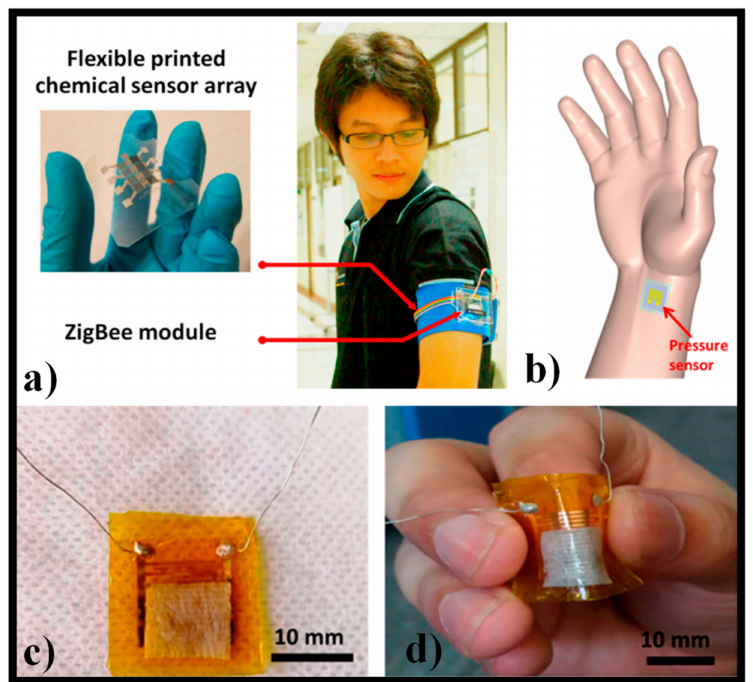
Figure 11. (a) Model of a wearable e-nose established on the adaptable inkjet-printed chemical sensor array incorporated in ZigBee wireless network. Reprinted from ref. [183]; ( b ) pressure sensor was attached to a human wrist for heart pulse detection. Reprinted from ref. [184]; ( c ) photograph of a manufactured pressure sensing device connected with Al wires. Reprinted from ref. [184]; ( d ) photograph of a bent pressure sensing device. Reprinted from ref.